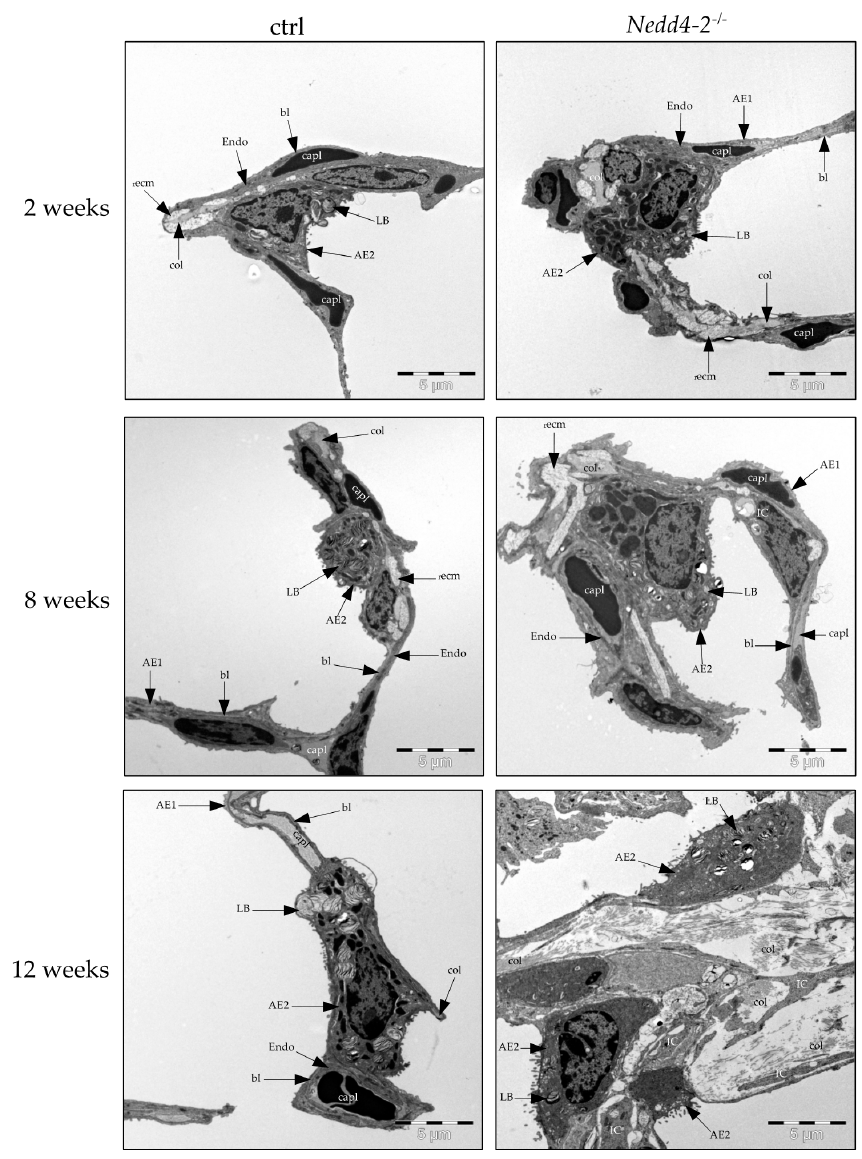
Figure 2. Composition of septal walls. Electron microscopic images of the ultrastructure of control (ctrl) and Nedd4-2 deficient lungs ( Nedd4-2 − / − ) after 2, 8 and 12 weeks of doxycycline induction. Increase of collagen fibrils, interstitial cells and alveolar epithelial type II (AE2) cells can be observed after 12 weeks. Abbreviations: AE1: alveolar epithelial type I cells; AE2: alveolar epithelial type II cells; LB: lamellar body; Endo: endothelial cells; IC: interstitial cells; r ecm: extracellular matrix without collagen fibrils; col: collagen fibrils; capl : capillary lumen (with erythrocyte); bl: basal lamina.